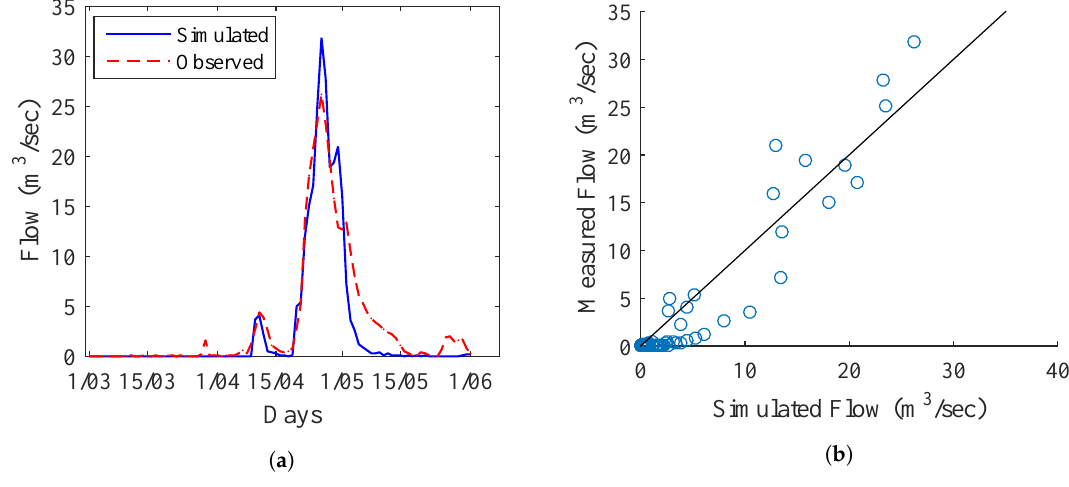
Figure 7. Continuous modelling of daily flow series for the Sturgeon Creek Watershed. The calibration is performed for 2014 from 1 March 2014–1 June 2014. ( a ) Comparison of observed and simulated hydrograph; ( b ) distributions of points are shown from the y = x